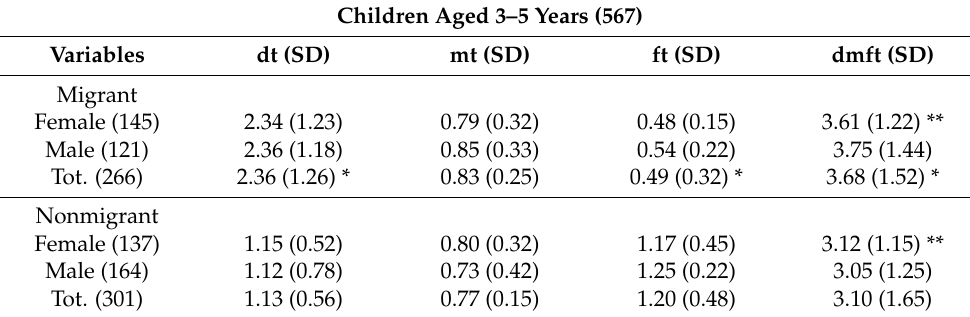
Table 2. dmft index and distribution of data in migrant and nonmigrant